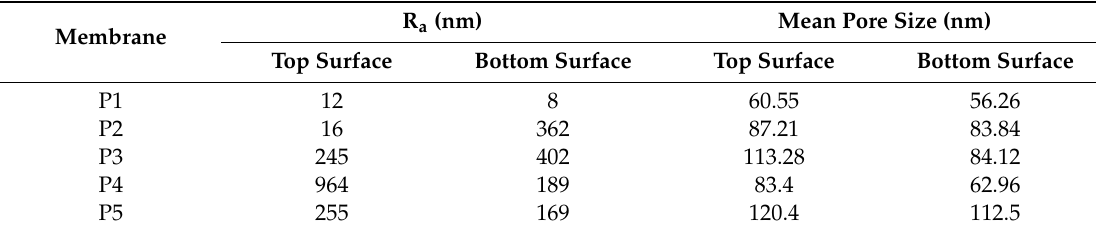
Table 3. Mean pore size and the mean roughness (Ra) of prepared membranes. Membrane